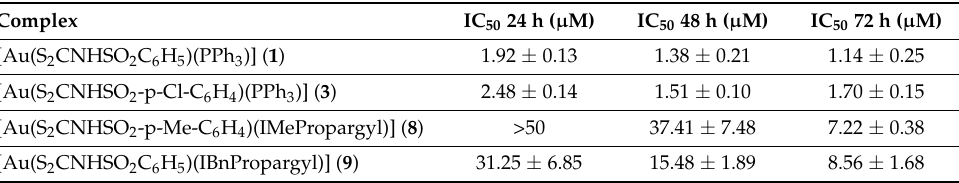
times of 24, 48 and 72